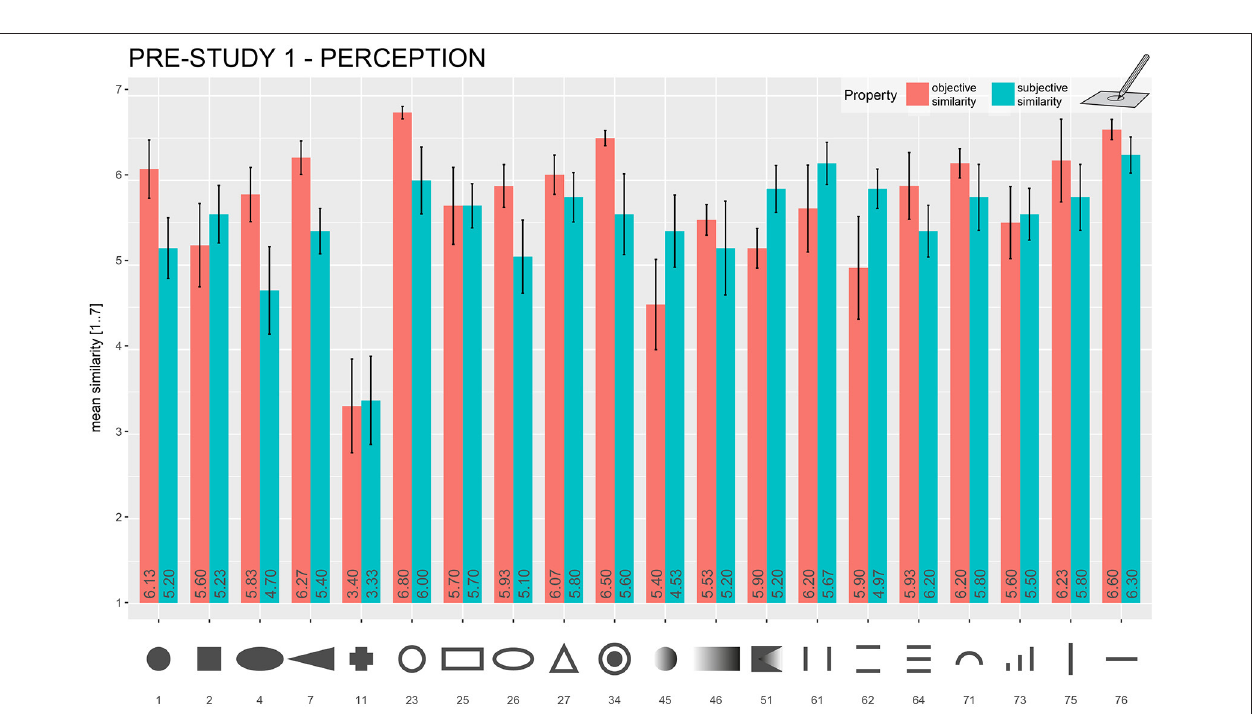
FIGURE 5 | Mean objective and subjective similarity ratings for the explored forms in Pre-Study 1 ( Drawing ) that were chosen to be used in further studies. The mean objective and subjective similarity rating is represented in each bar. Error bars = ± 1 standard error of the mean.